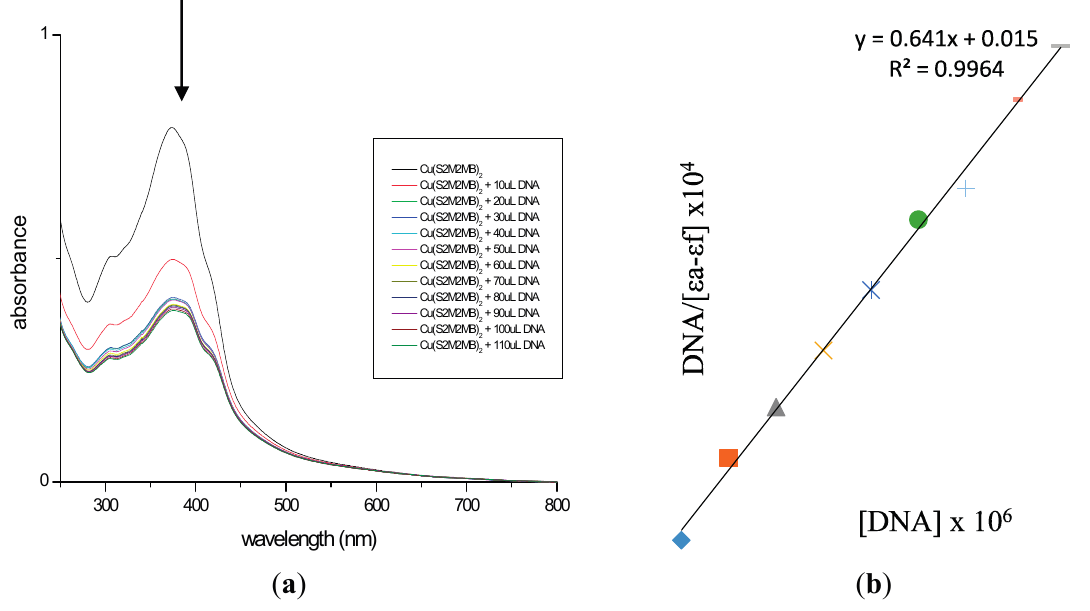
Figure 6. ( a ) Electronic absorption spectrum of 3 ; ( b ) Plot of [DNA]/ ε a −ε f vs. [DNA] for absorption titration of DNA with 3 . (The arrow indicates the change in absorbance in tandem with increasing DNA concentration.).